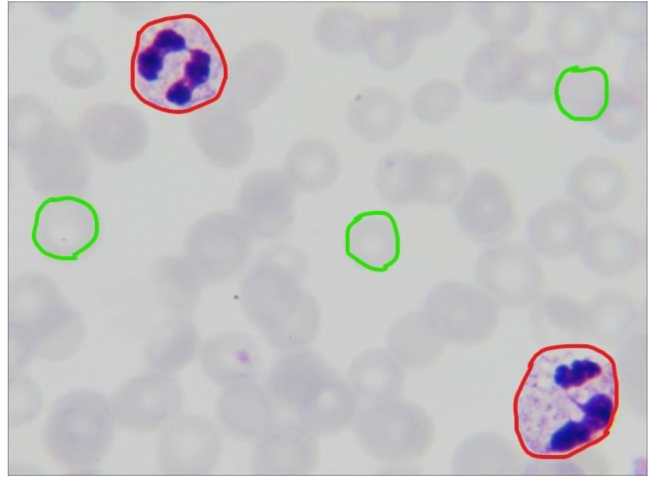
Figure A1. Microscopic Blood smear images of the dataset: Red color marked cells are the parasitized cells; Green color marked cells are some instances of uninfected